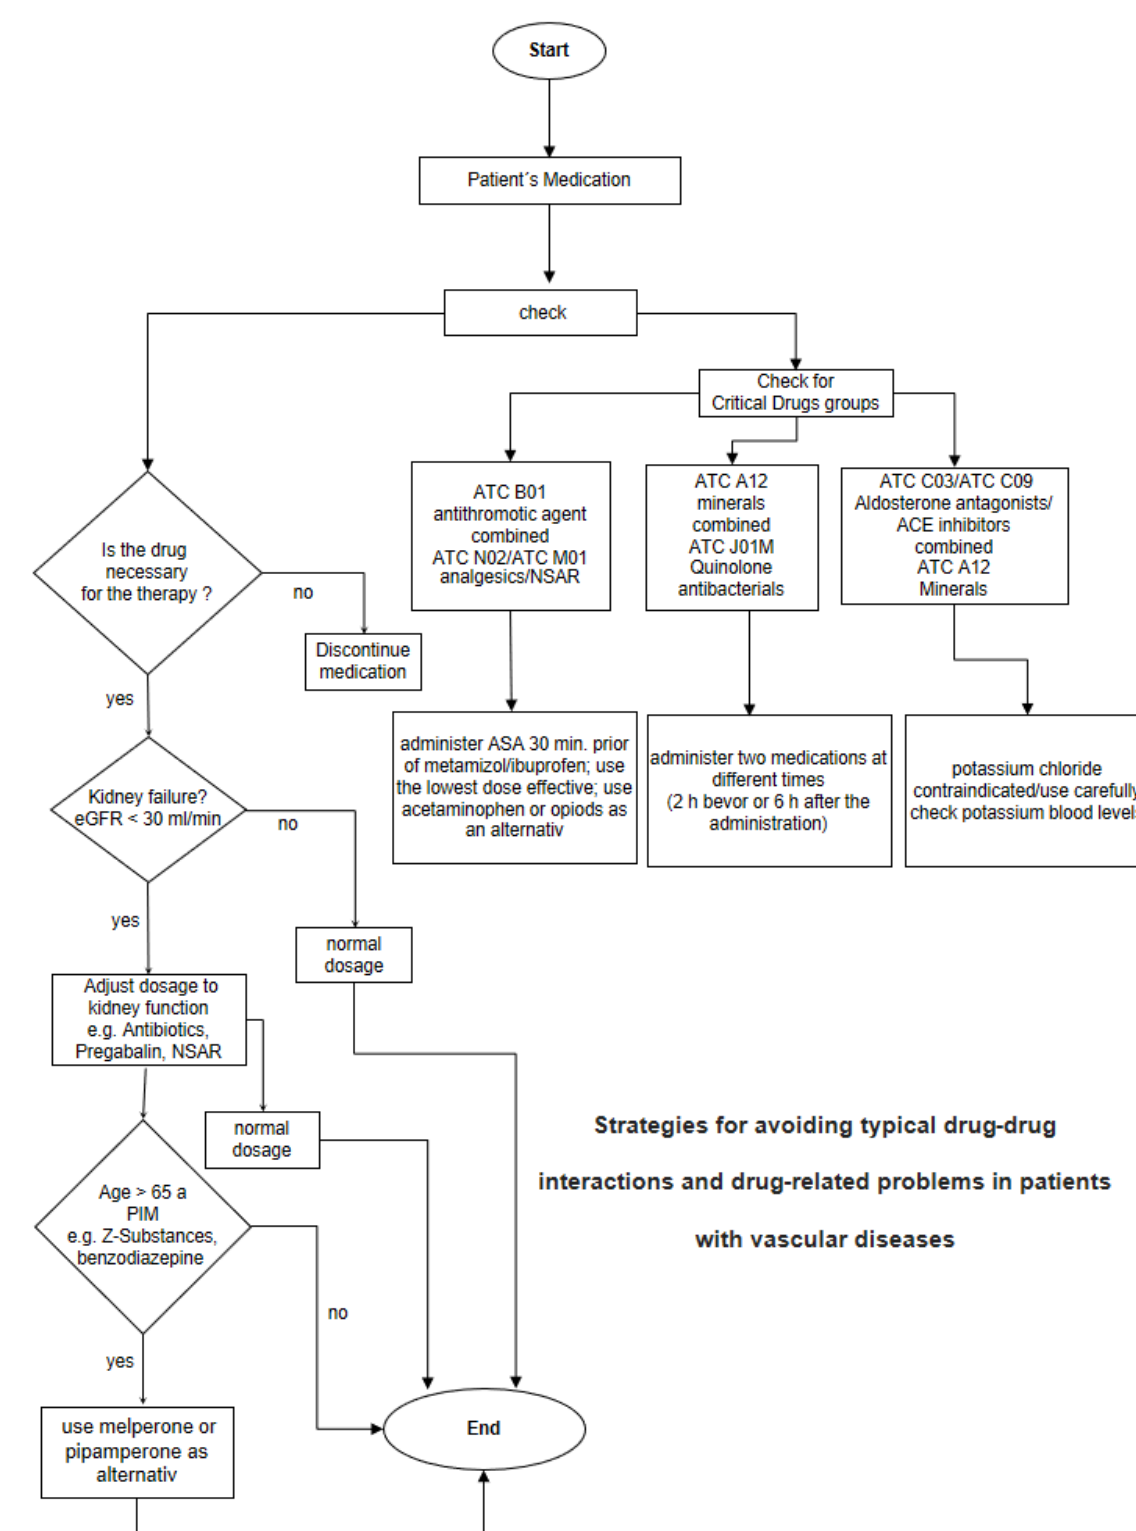
Figure 1. Workflow to systematically avoid the most common DRPs identified in this study.